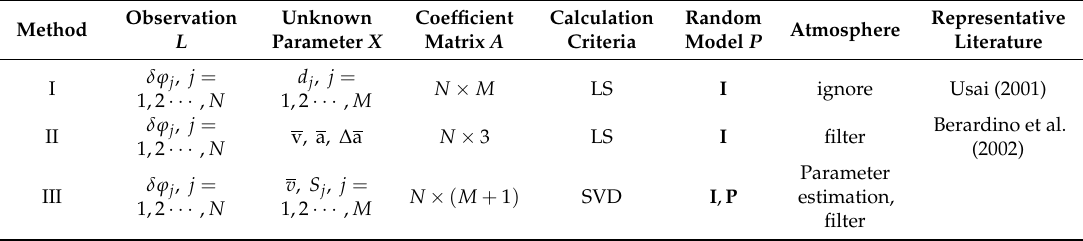
Table 1. Summary of the methods used to obtain the deformation